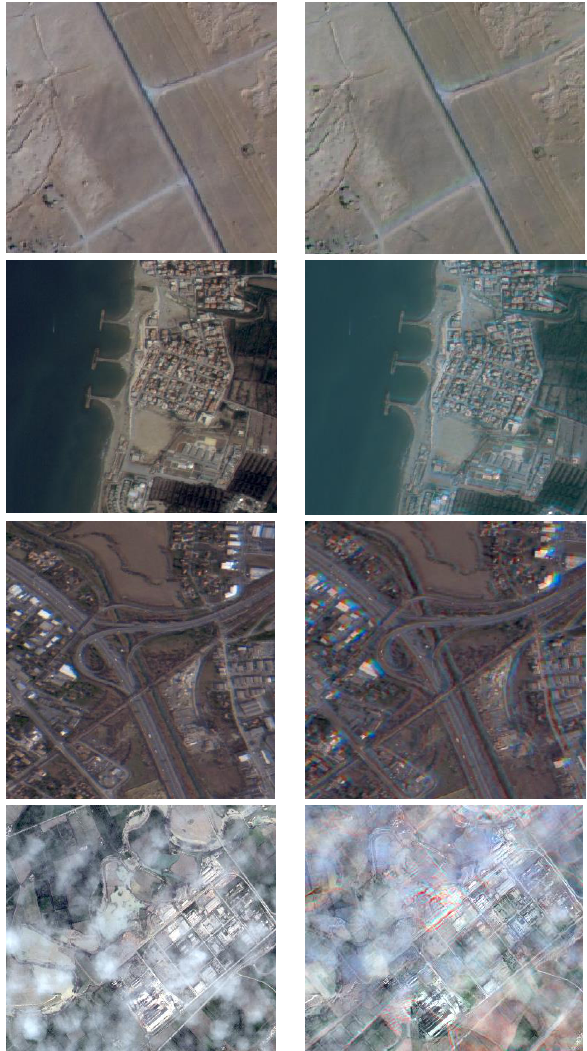
Figure 2. Visual samples from the pan-sharpened images before (Right) and after (left) the